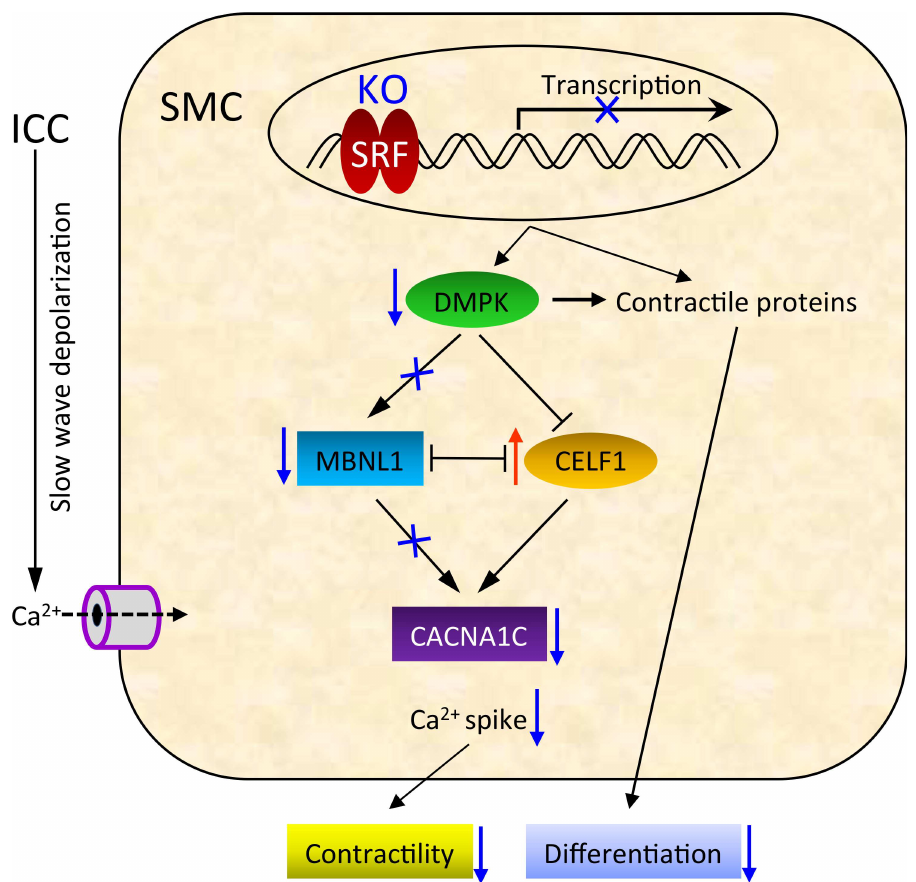
Fig 7. Model showing the possible molecular pathways by which SRF regulates contractility via DMPK and CACNA1Cin